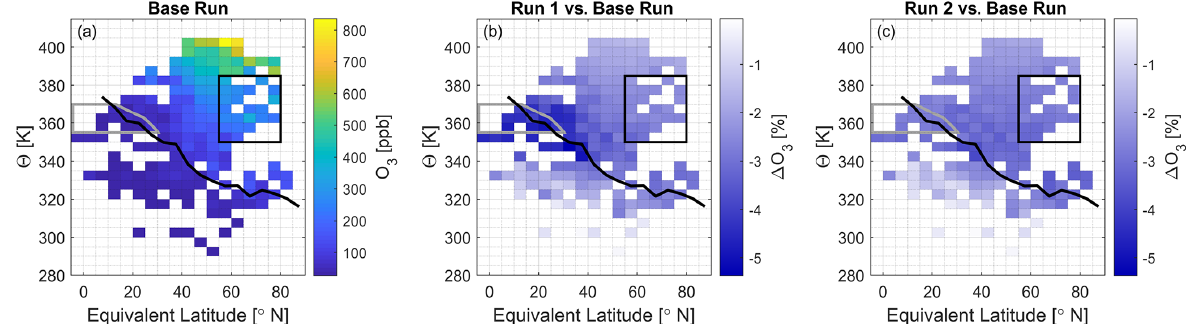
Figure 13. TOMCAT model results of O 3 impacted by elevated Br tot in the UTLS. Panel (a) displays the O 3 VMR distribution from the base run using constant Br tot boundary conditions along the TP (see Table 3). Panel (b) shows the relative percentage (cid:49) O 3 between run 1 with elevated Br tot in the tropical UT and the base run. Panel (c) displays the relative (cid:49) O 3 between run 2 and the base run. The solid black line is the campaign-average WMO TP, the black box in the LMS is the HBrR, and the gray outline marks the tropical (cid:50) high –PV low